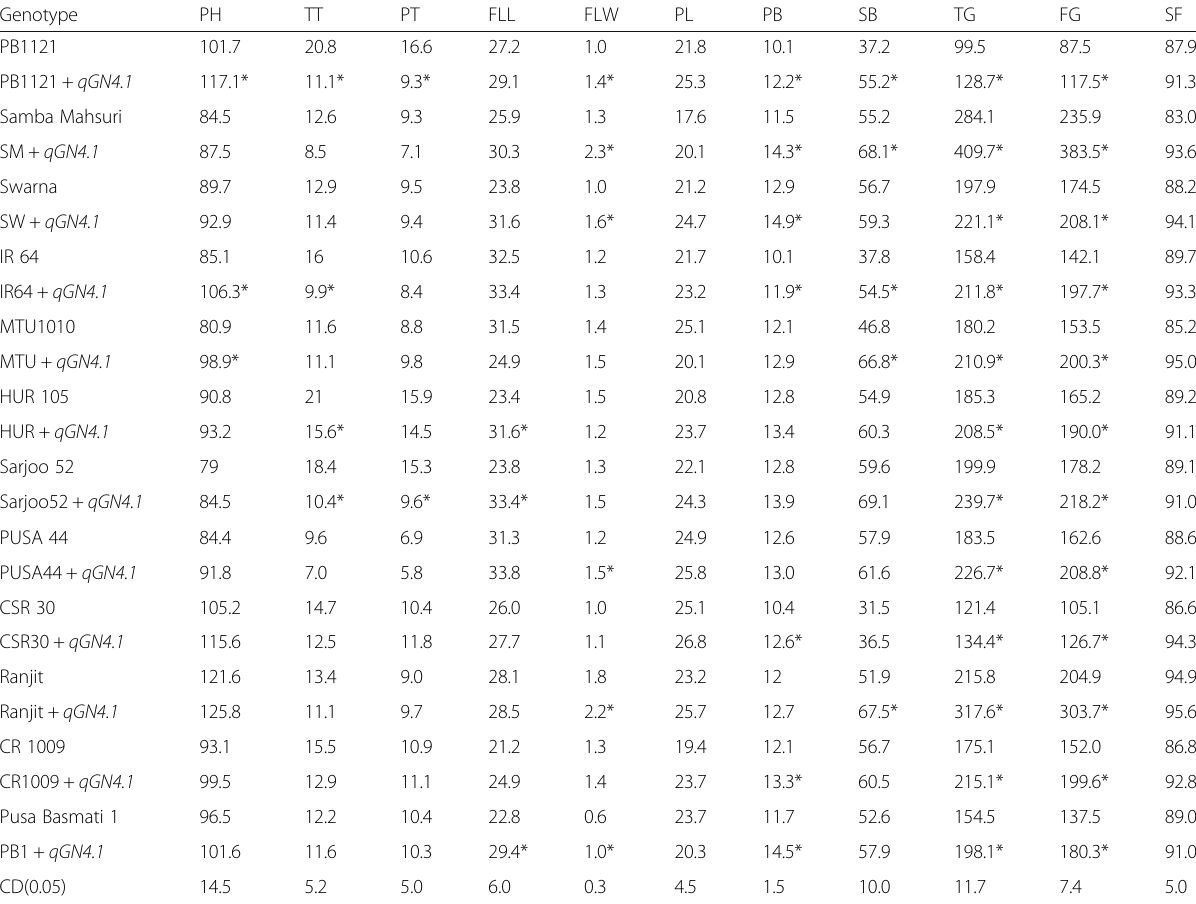
Table 1 Adjusted Means for Different Morphological Traits for the qGN4.1 QTL-NILs Compared With Respective Recipient Parents in BC 2 F 3 Generation